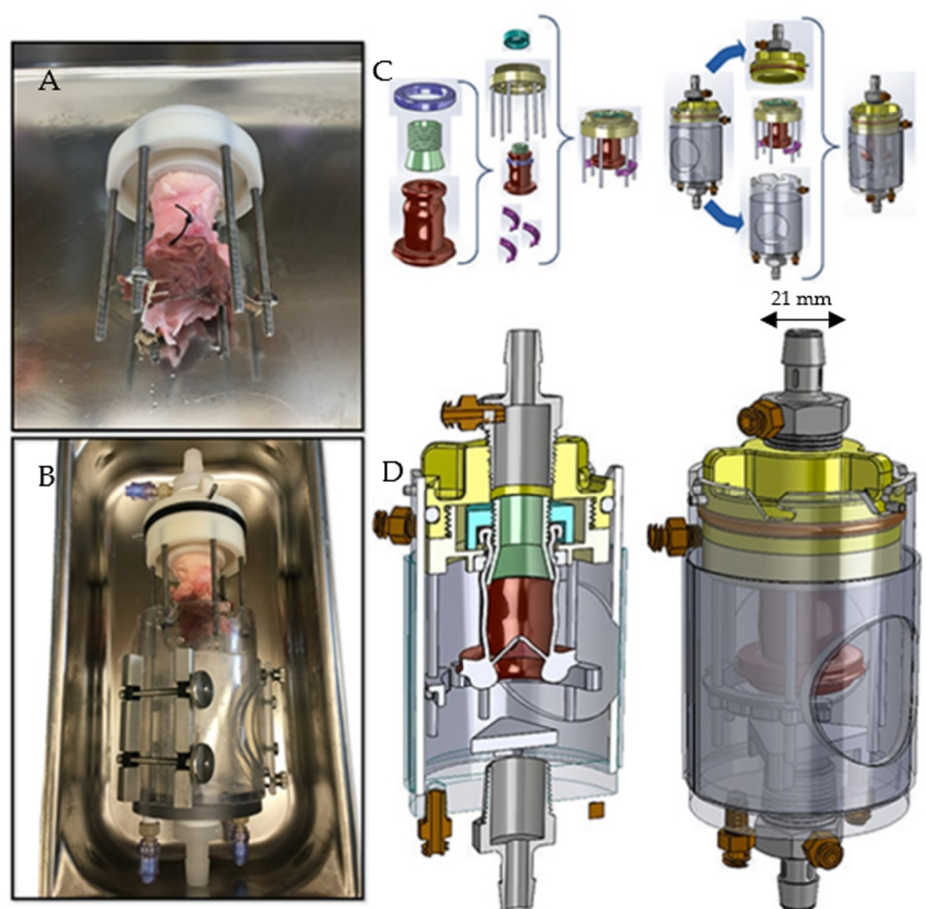
Figure 1. A picture and technical diagram of the 3D valve suspension chamber showing how the heart valves were suspended. ( A ) Surgical attachment of the heart valve to the outflow tract of the simulator. ( B ) Subsequent suspension of the valve in the valve chamber. ( C ) The different components of the 3D printed valve suspension chamber. The valve was first sutured to the outflow nozzle as seen in ( A ) and then inserted into the suspension chamber depicted in ( B ). ( D ) Diagram of assembled suspension chamber. The internal width of the valve annulus was 21 mm.